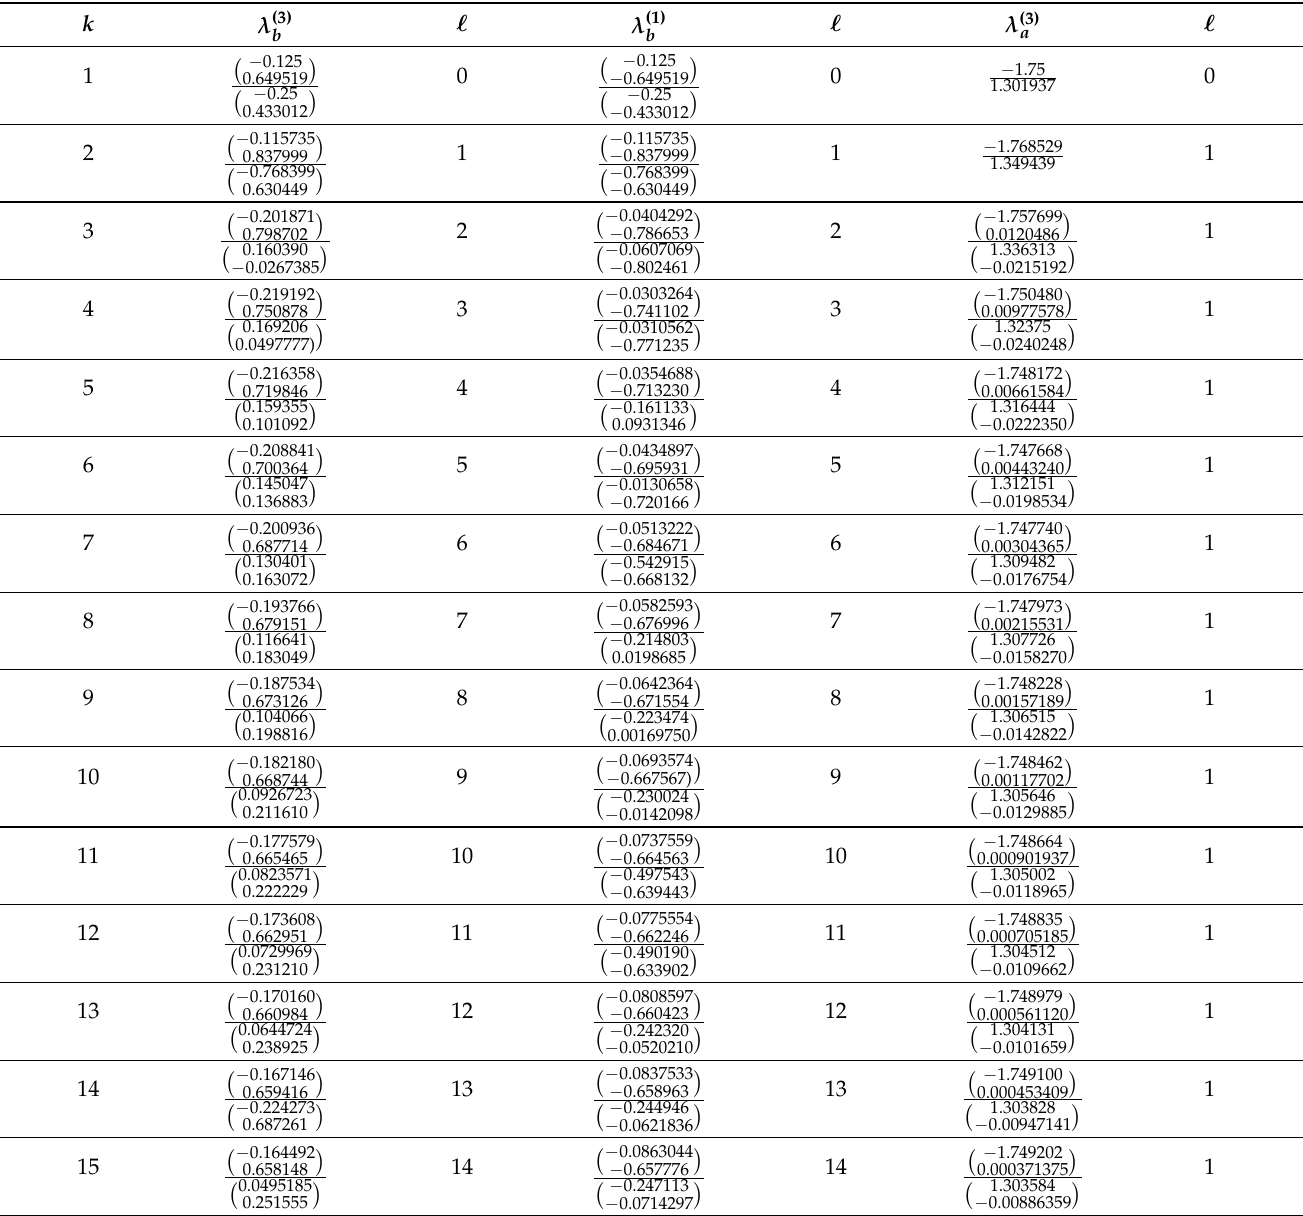
Table 2. Typical λ (cid:96) , k along B 1 and B 3 for 1 ≤ k ≤ 15 and 0 ≤ (cid:96) ≤ ξ (cid:96) , k